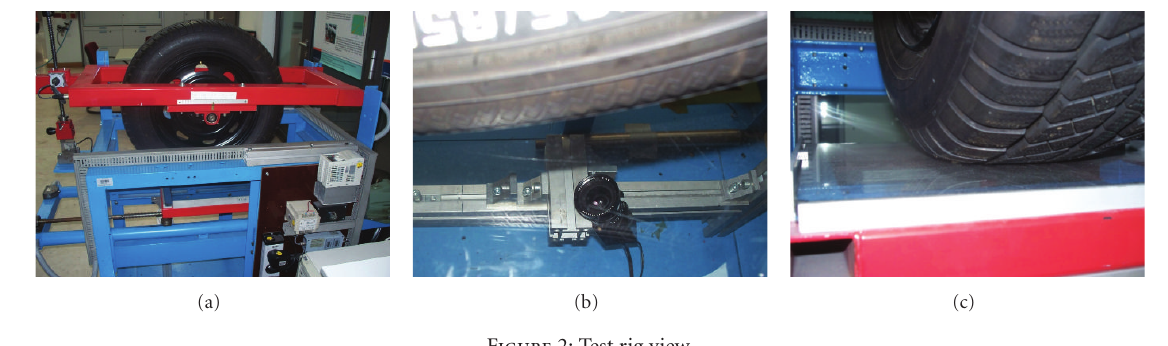
Figure 2: Test rig view.